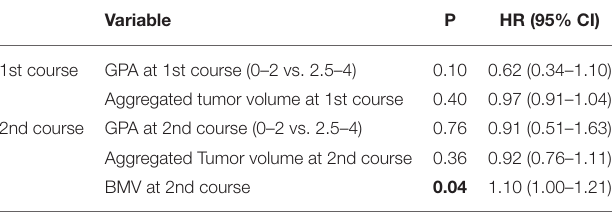
TABLE 4 | Multivariate analysis of correlation to overall survival course-specifically. FIGURE 6 | Toxicity. Acute toxicity graded according to Criteria for Adverse